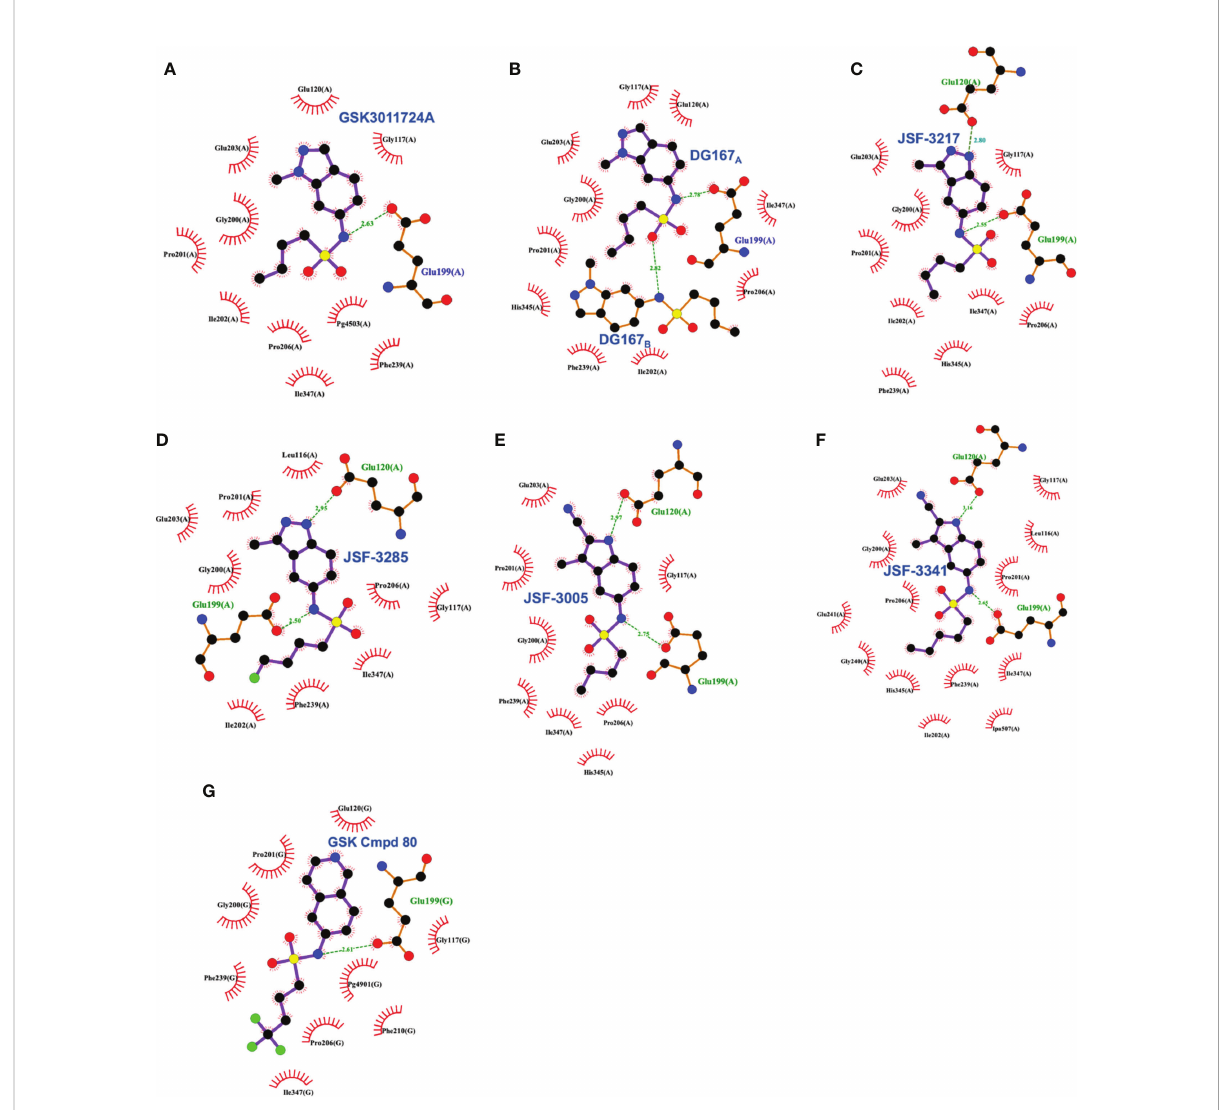
FIGURE 9 Interaction pro fi les for wild type KasA bound to the following sulfonamides: (A) GSK3011724A (PDB ID 5LD8), (B) DG167 (PDB ID 5W2P), (C) JSF- 3217 (PDB ID 5W2S), (D) JSF-3285 (PDB ID 6P9L), (E) JSF-3005 (PDB ID 6P9K), (F) JSF-3341 (PDB ID 6P9M), and (G) GSK Cmpd 80 (PDB ID 6Y2J). Hydrogen bonds are shown as green dashed lines and distances are measured in